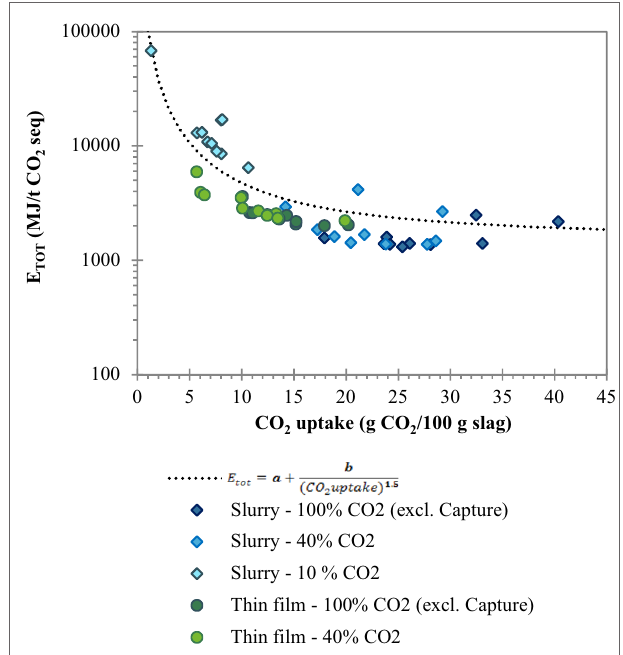
FigUre 7 | Trend of total energy requirement e TOT of the slurry-phase and thin-film routes as a function of the carbonation yield